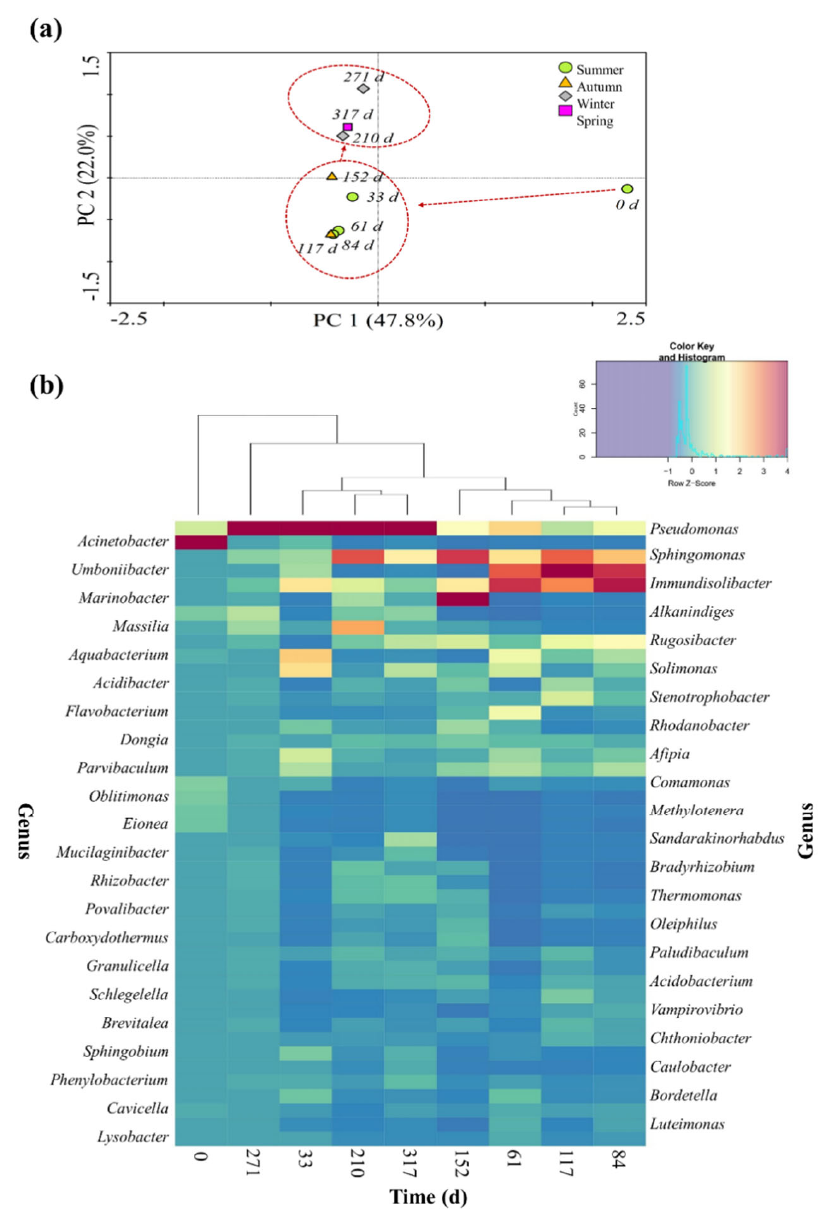
Figure 4. Seasonal changes in the soil bacterial community. ( a ) Principal component analysis (PCA) of the bacterial community structure in the soil. ( b ) Hierarchically clustered heat map of the bacterial distribution at the genus level. The rows represent different soil samples and the columns indicate the relative abundance of each bacterial group. The relative abundance is denoted by the intensity of the color.